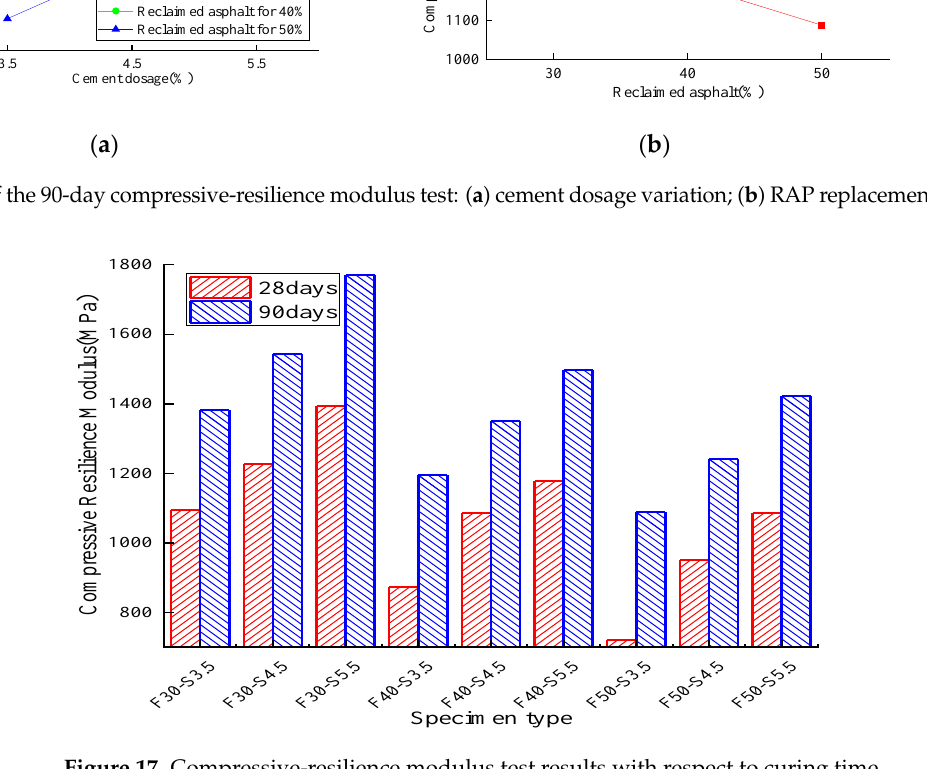
Figure 17. Compressive-resilience modulus test results with respect to curing time.